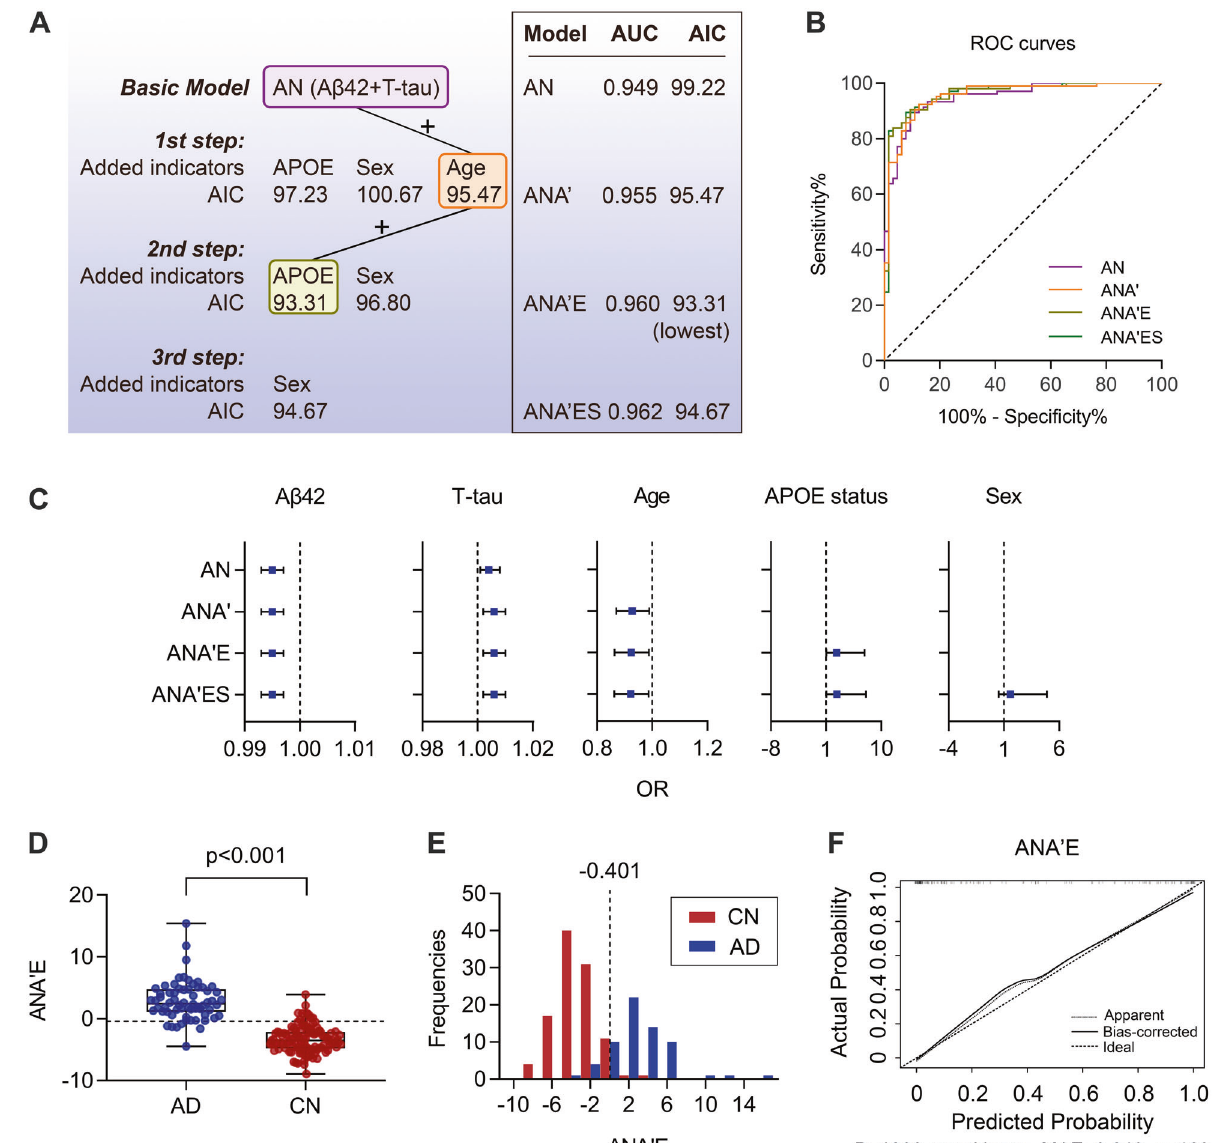
Fig. 4 Integrative models of demographic characteristics with CSF biomarkers. A Model selection process. The data-driven model was selected with the lowest AIC ( Δ AIC > 2). Based on the AN model, age, sex, and APOE ε 4 status were added in a stepwise procedure, the model with lower AIC was obtained by adding one indicator at each step. B ROC Curves of integrated model indices. C OR values represent the contribution of each indicator to the integrated models. The error bars represent 95% con fi dence intervals. D Comparison of ANA ’ E index between AD ( n = 64) and CN ( n = 105) group. Boxes represent the 25th, 50th, and 75th data percentiles. Whiskers represent the lowest and highest data. The dashed lines indicate the cutoff value for ANA ’ E index. E Frequency distribution of ANA ’ E index. The dashed vertical lines indicate the cutoff values for ANA ’ E index. F The bootstrap-validated of CSF ANA ’ E index. The Y-axis indicates the actual probability of AD and the X-axis indicates the predicted probability of AD. A, A β 42; T, P-tau181; N, T-tau; A ’ , age; E, APOE ε 4 status; S, sex; APOE ε 4, apolipoprotein E ε 4 allele; ROC, receiver operating characteristic curve; AUC, area under the curve; AIC, Akaike information criterion; OR, odds ratio; AD, Alzheimer ’ s disease; CN, cognitively normal; MAE, mean absolute